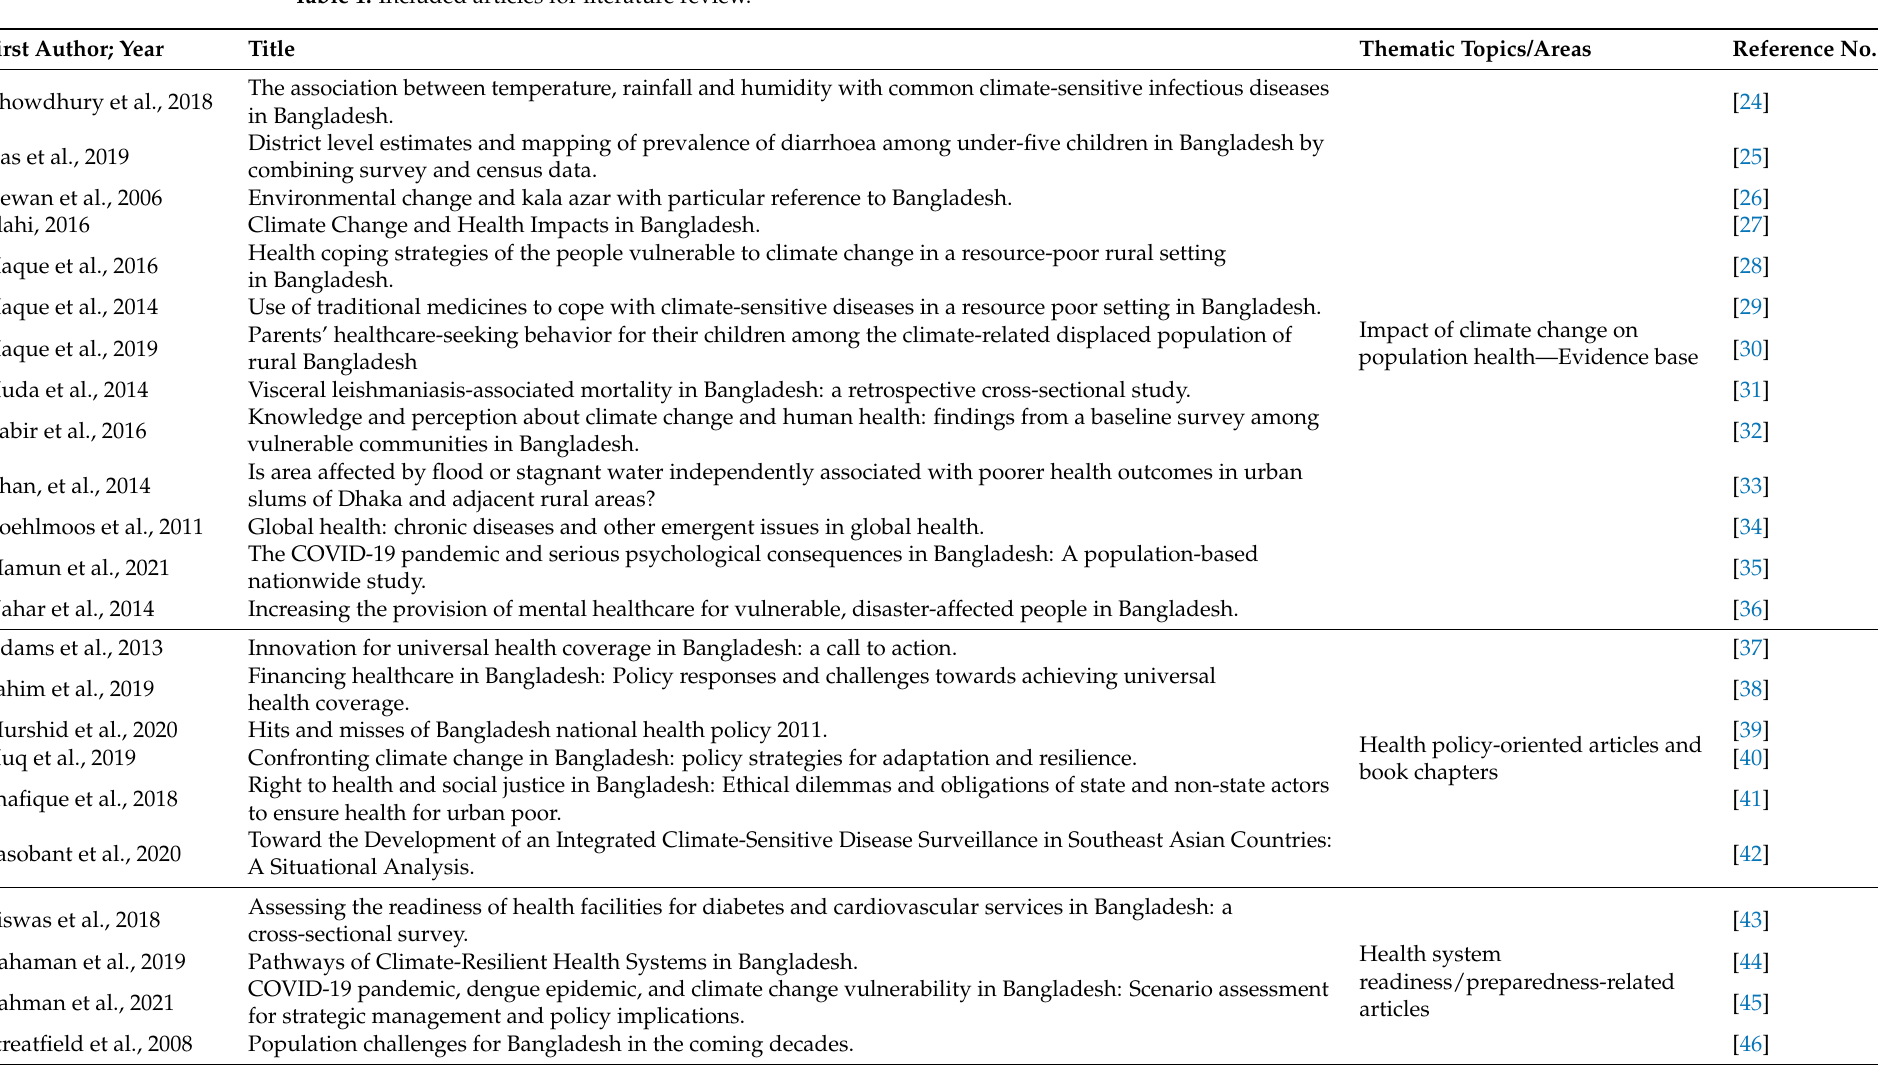
Table 1. Included articles for literature